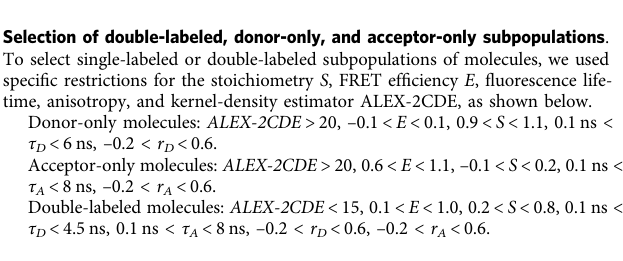
where F BR = S BR – B BR is the background-corrected number of photons in the red detection channels independently of the polarization after blue excitation (with S BR and B BR being the summed intensity and background, respectively, in the time gates BR ∥ and BR ⊥ ); F BB = S BB – B BB is the background-corrected number of pho- tons in the blue detection channels after blue excitation (with S BB and B BB being the summed intensity and background, respectively, in the time gates BB ∥ and BB ⊥ ), F RR = S RR – B RR is the background-corrected number of photons in the red detection channels after red excitation (with S RR and B RR being the summed intensity and background, respectively, in the time gates RR ∥ and RR ⊥ ), de — the correction factor for direct excitation of the acceptor with the 483 nm laser, ct — the The corrected stoichiometry ratio S was calculated